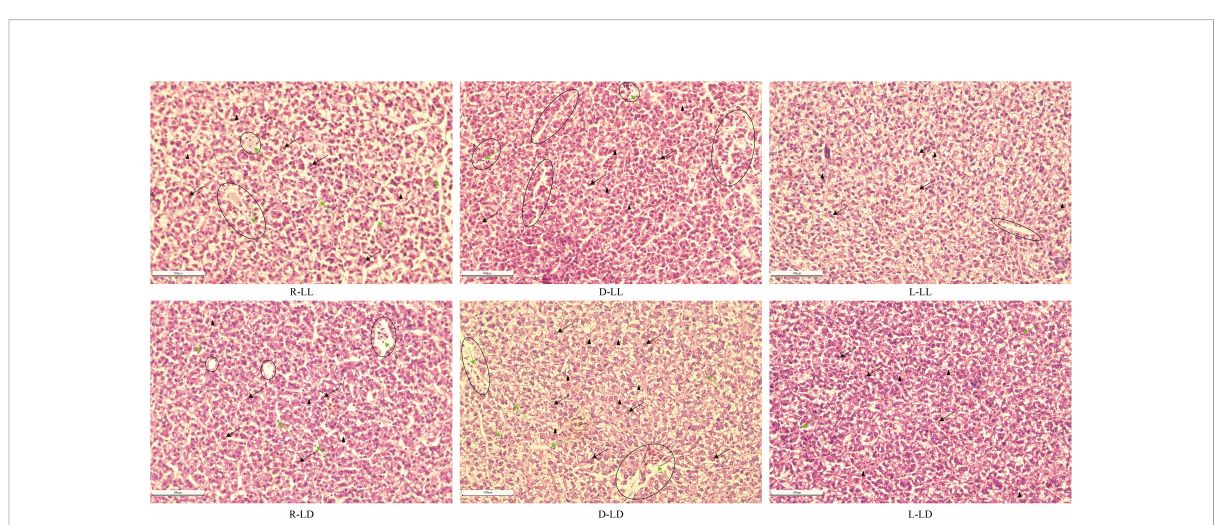
FIGURE 8 The histology of the liver in juvenile Oncorhynchus mykiss under different experimental treatments (200 × magni fi cation, scale bars = 100 m m, slice thickness = 7 m m). R: random feeding, D: mid-dark stage feeding, L: mid-light stage feeding, LL: 24L: 0D, LD: 12L: 12D. The black arrow points to hepatocyte; the green arrow points to blood sinusoid including erythrocyte; the black triangle points to cavitation; the black circle points to vein including